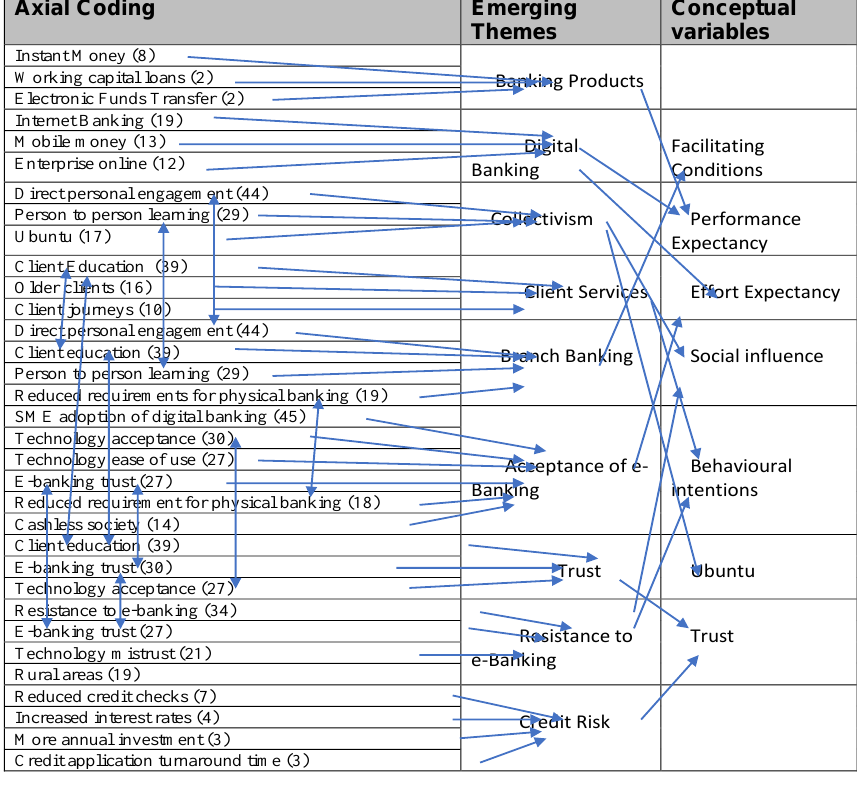
Figure 1: Relationship between coding and emergent themes; Source: Researchers’ own compilation